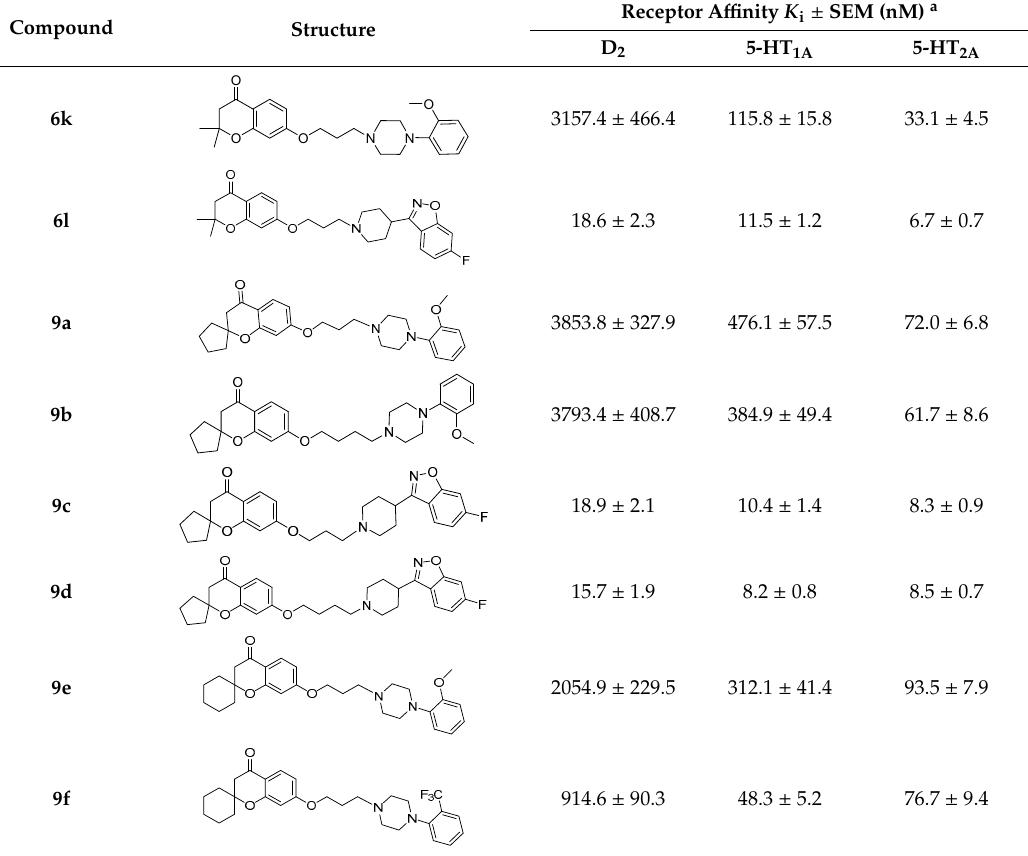
Table 2. Table 2. Binding Affinities for D 2 , 5-HT 1A , and 5-HT 2A Receptors of Compounds and Reference Reference Antipsychotics. Table 2. Binding Affinities for D 2 , 5-HT 1A , and 5-HT 2A Receptors of Compounds and Reference Table 2. Binding Affinities for D 2 , 5-HT 1A , and 5-HT 2A Receptors of Compounds and Reference Table 2. Binding Affinities for D 2 , 5-HT 1A , and 5-HT 2A Receptors of Compounds and Reference Table 2. Binding Affinities for D 2 , 5-HT 1A , and 5-HT 2A Receptors of Compounds and Reference Table 2. Binding Affinities for D 2 , 5-HT 1A , and 5-HT 2A Receptors of Compounds and Reference Antipsychotics. Table 2. Binding Affinities for D 2 , 5-HT 1A , and 5-HT 2A Receptors of Compounds and Reference Antipsychotics. Table 2. Binding Affinities for D 2 , 5-HT 1A , and 5-HT 2A Receptors of Compounds and Reference Antipsychotics. Antipsychotics. Antipsychotics. Antipsychotics. Antipsychotics. Compound